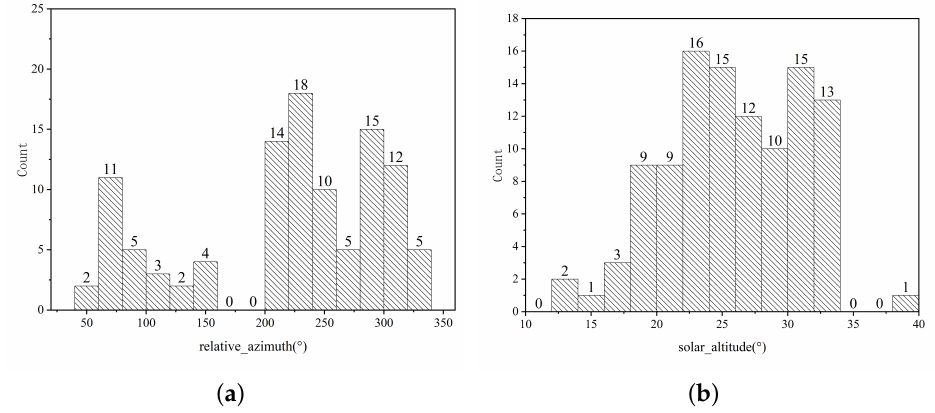
Figure 5. Histogram of the distribution of illuminance and observation angle in the first 24 lunar days. ( a ) Relative azimuth angle statistics, with an interval of 20 ◦ . The relative azimuth is the difference in the solar incident light azimuth and emission light azimuth. ( b ) Solar altitude angle statistics, with an interval of 2 ◦